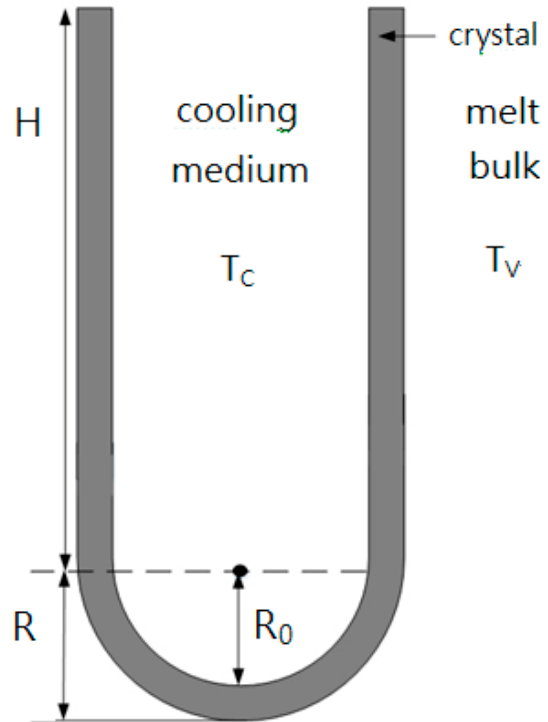
Figure 4. Schematic diagram of the crystal layer on the cooled cylindrical tube of the cooling finger (R 0 = 0.01 m and H = 0.10 m ).